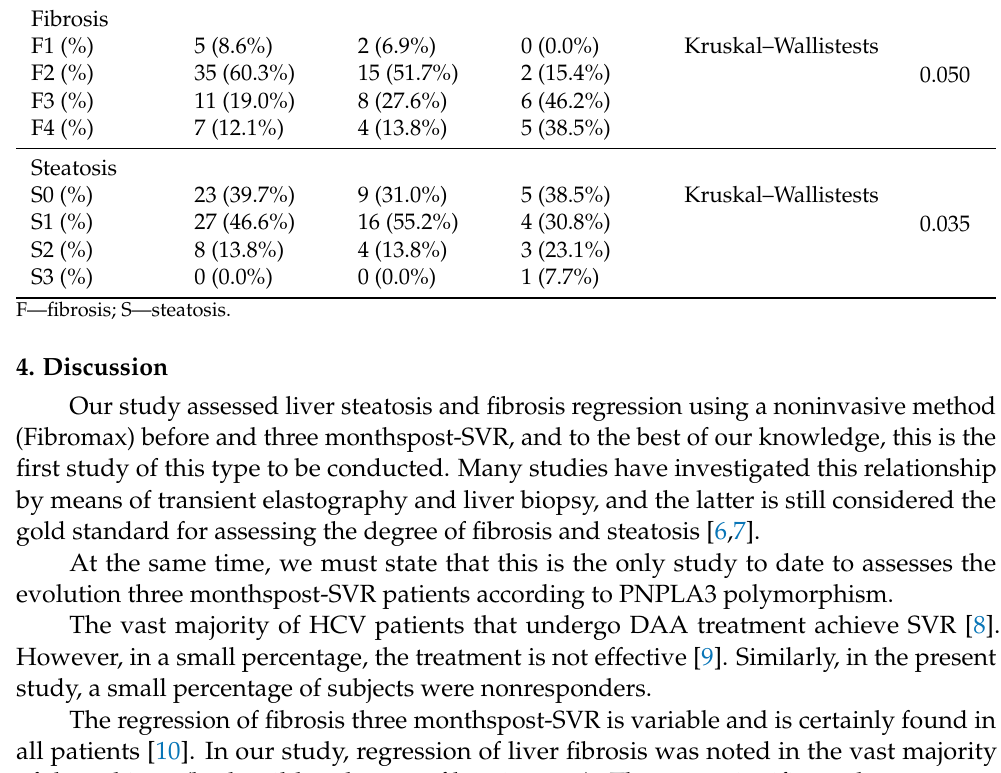
domain-containing3.